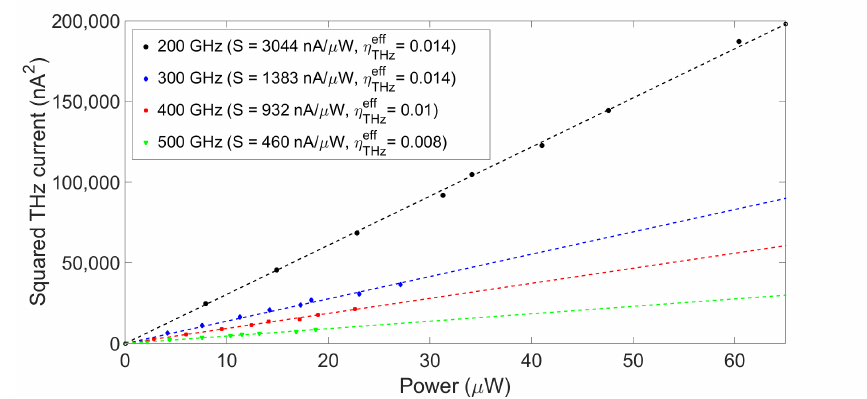
Figure 4. Squared detected THz current versus measured THz power for PCA B. The fitted responsivity S ( f ) (shown in dashed lines) was equated to Equation (10) in order to obtain the effective THz effiency η ef f . The minimum THz power that could be measured was limited by the sensitivity of the THz PTB calibrated detector (1 µ